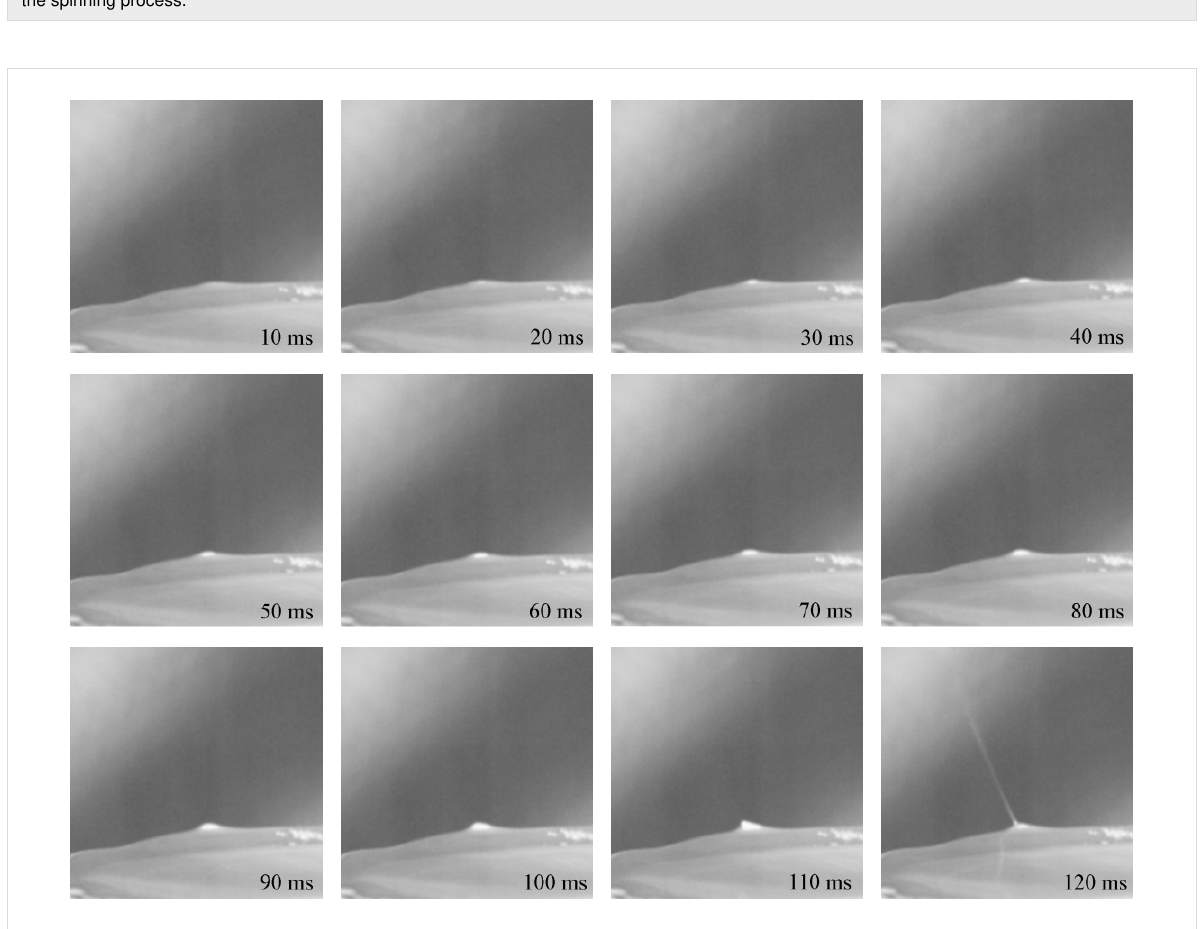
Figure 5: Time-lapse images (10–120 ms) of the jet initiation process of OSFSE. The voltage was turned on and held at an amplitude of 40 kV throughout the spinning